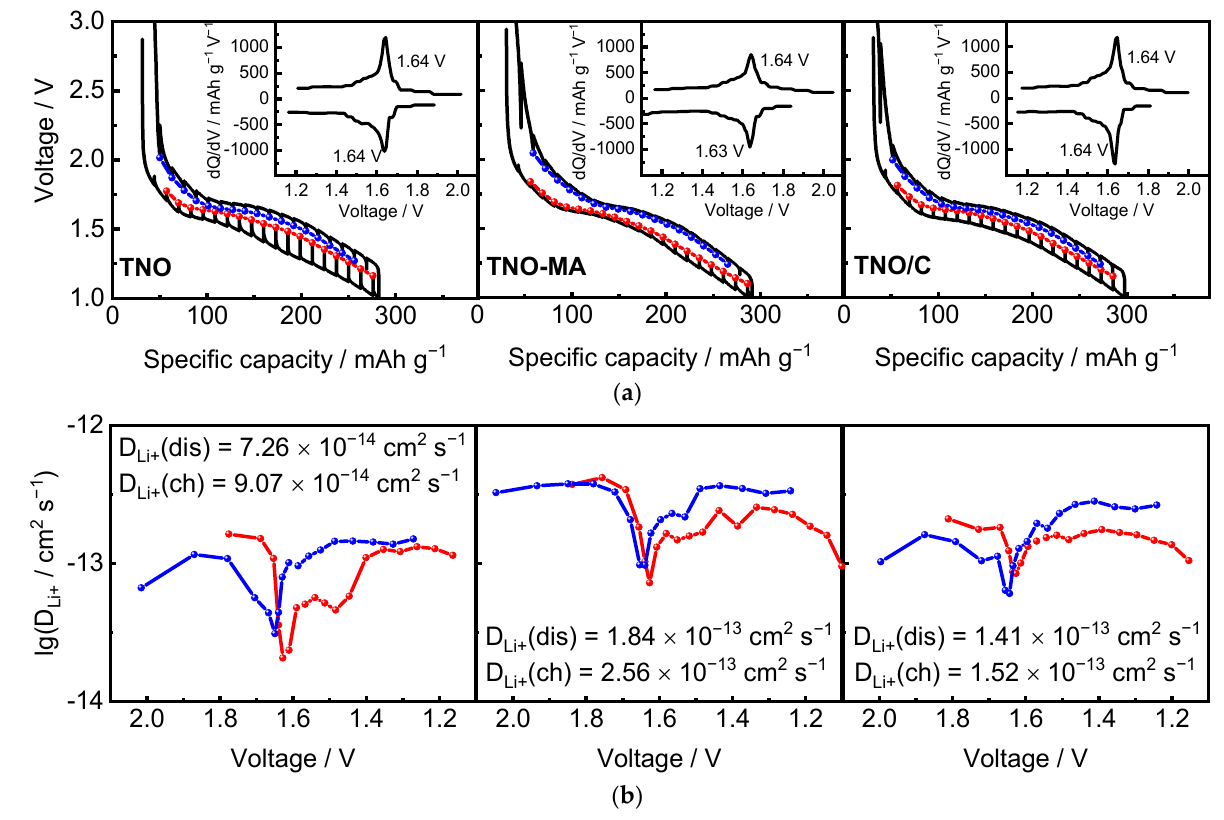
Figure 11. ( a ) GITT and OCV curves; ( b ) diffusion coefficient D Li+ as a function of xLi for TNO, TNO-MA, and TNO/C on the 2nd cycle. Differential capacities, derived from OCV curves, are insets.